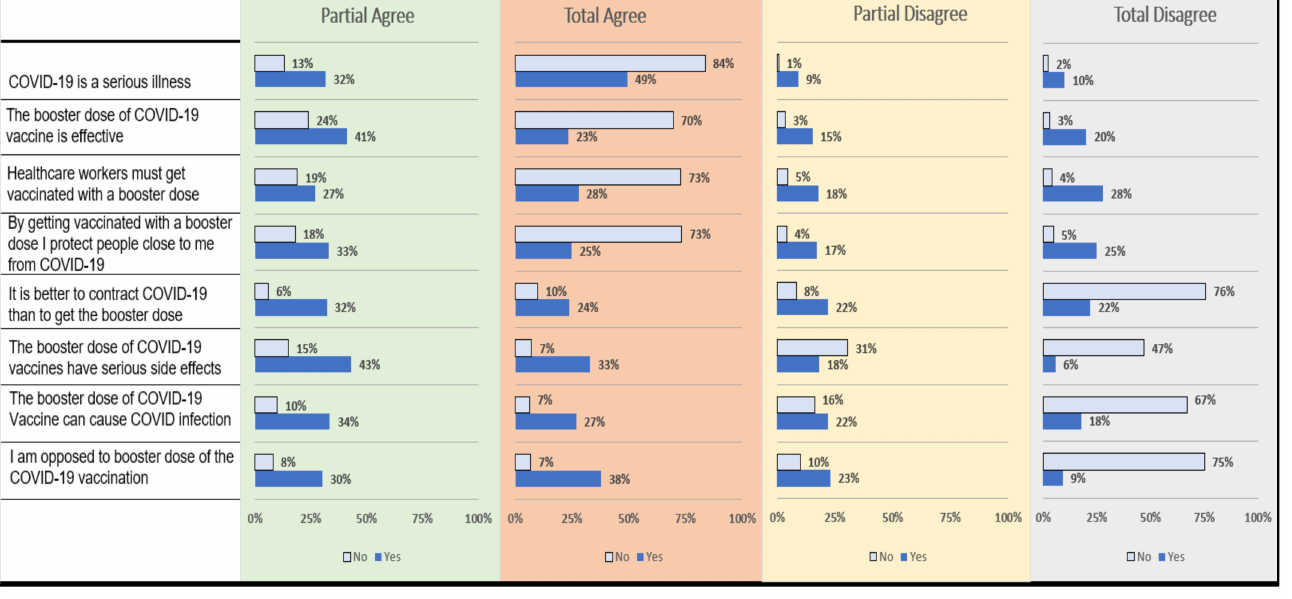
Figure 2. Item-wise comparison of vaccine confidence index among booster dose hesitant (yes) and non-hesitant (no) groups. Note: All differences were statistically significant. Table 5. Pearson correlations, and reliability estimates for study variables in the sample population ( n =